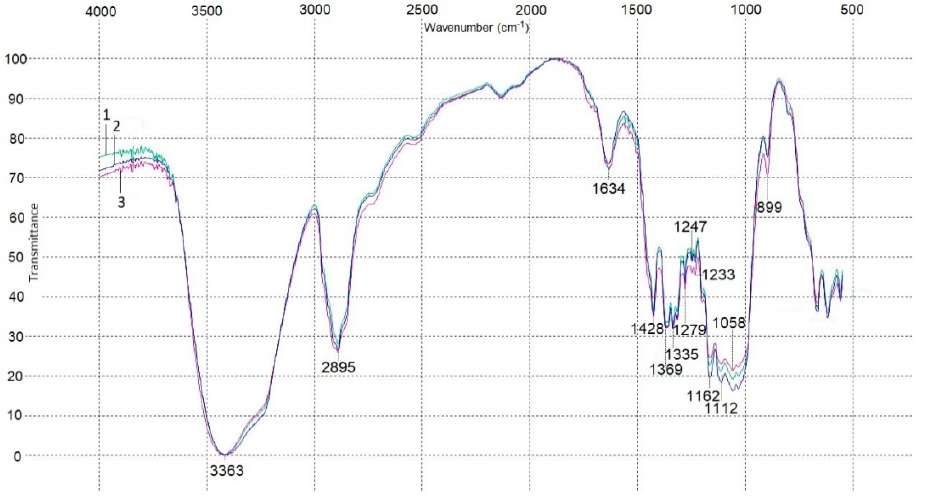
Figure 5. IR spectroscopy data for BNC sheets: 1—Sheet 1; 2—Sheet 2/1; and 3—Sheet 2/2.